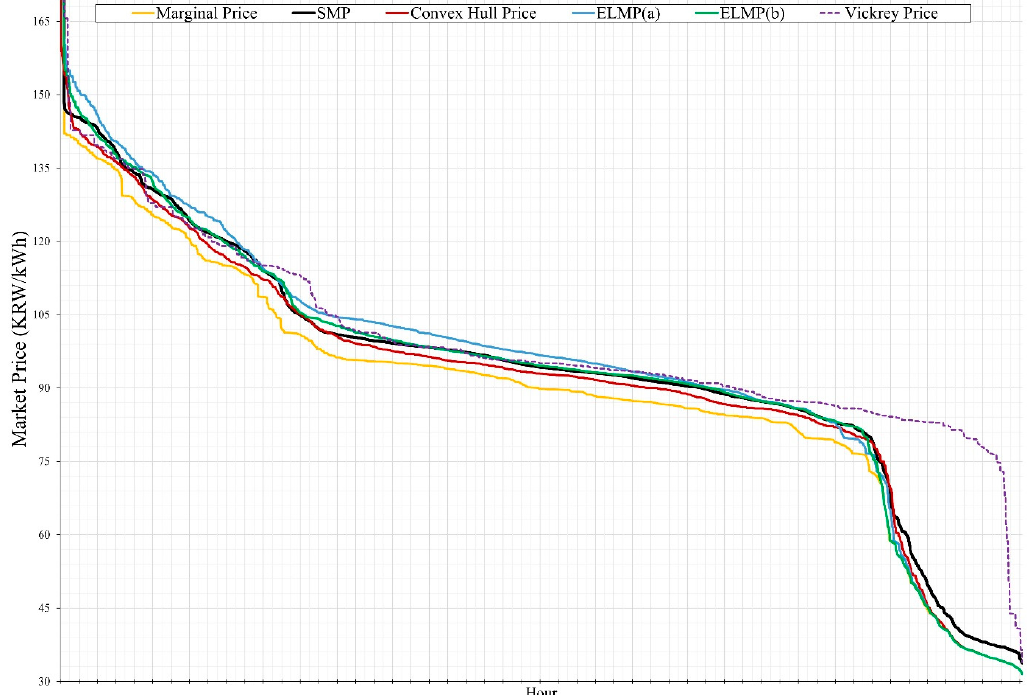
Figure 4. Price duration curves by market price for 2015.